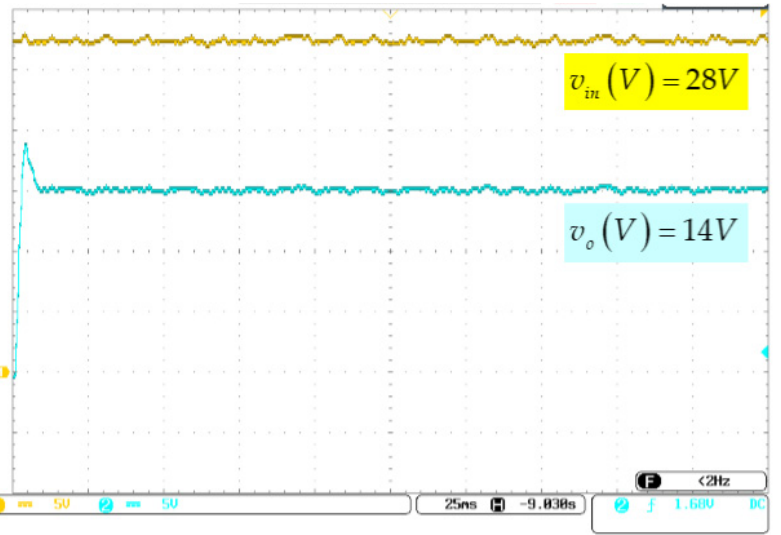
Figure 19. Experimental results of output voltage without changes in the input voltage.